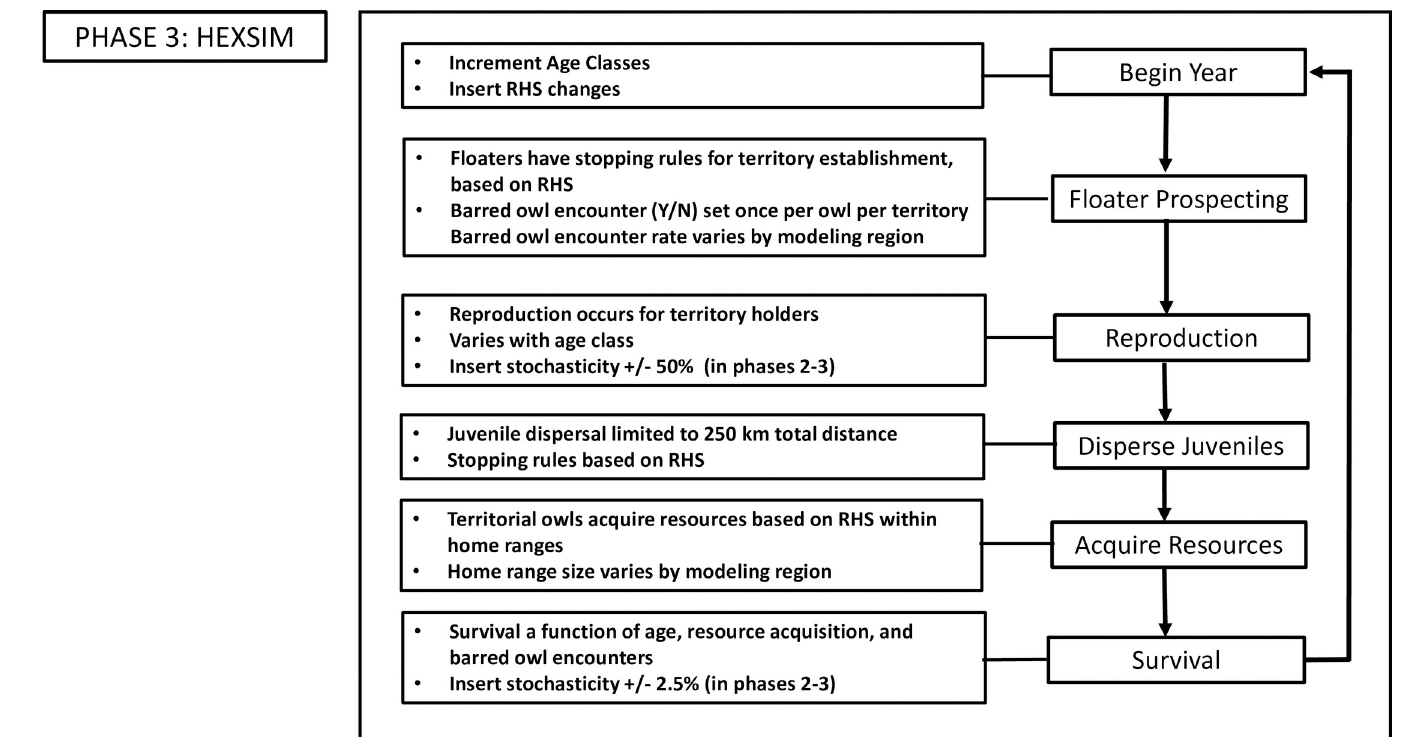
Fig 5. Flowchart of generalized steps involved in the northern spotted owl HexSim model.